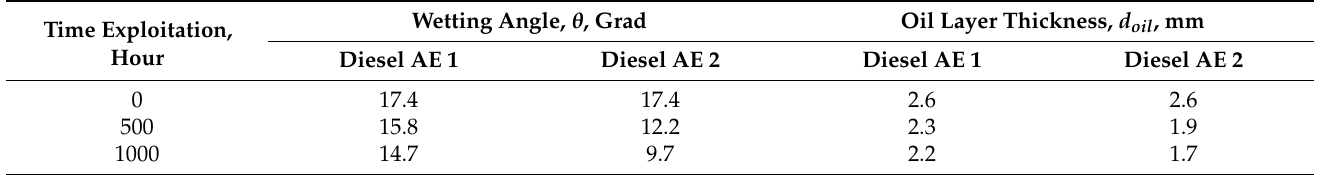
Table 4. Dynamics of changes in the structural characteristics of engine oil Shell Gadinia AL 40.